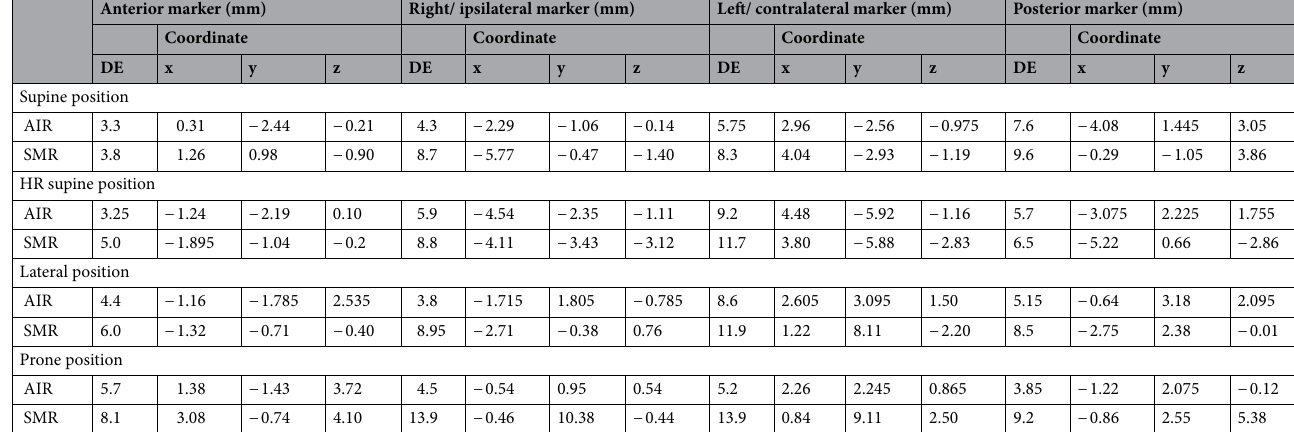
Table 2. Distance error of fiducial markers between imaging space and patient space. AIR Automatic intraoperative registration, DE Distance error, SMR Surface-merge registration.